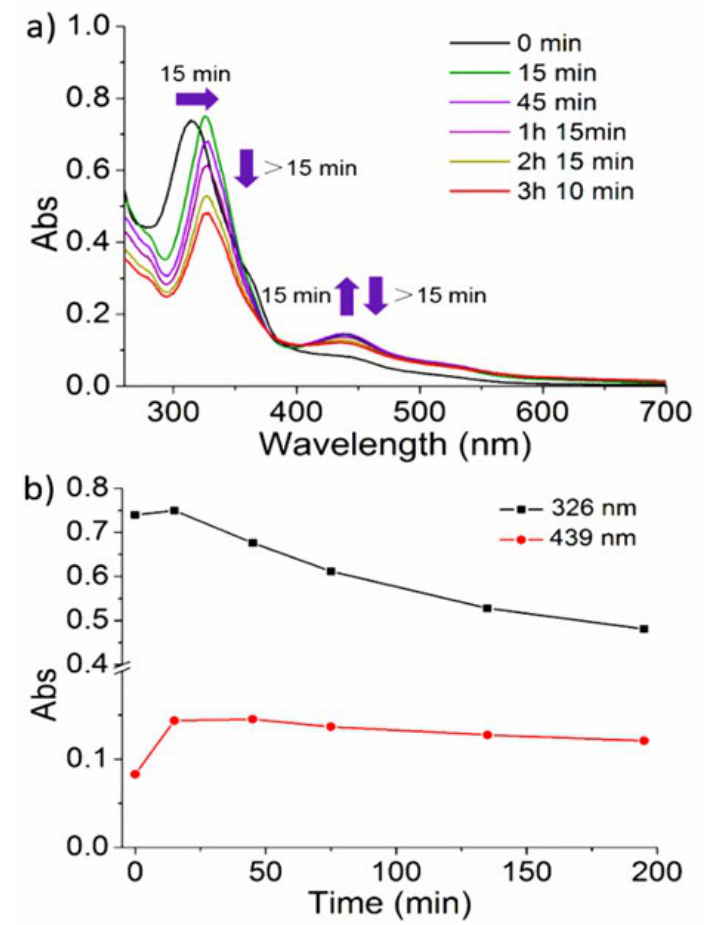
Figure 4. ( a ) Evolution of the UV-Vis spectra of a PBS suspension of RuBIS CPNs upon green light (λ exc = 532 nm); ( b ) plot of absorption changes at 326 nm (black) and 439 nm (red). Irradiation with 450 nm (0.35 W/cm 2 ) for the first 10 min showed a red shift of the main band, from λ max = 315 to 326 nm and an intensity increase in the shoulder at λ abs = 439 nm. Irradiation for longer periods (up to 2.5 h) evidenced an intensity decrease in both bands, including the shoulder at λ abs = 365 nm until its disappearance (Figure S11) and an isosbestic point at λ iso = 406 nm. This time-dependent two-step process was tentatively explained by an initial fast formation of photoinduced intermediate species (t irradiation ≤ 10 min) and a subsequent slower photochemical reaction (t irradiation > 10 min) leading to the forma- tion of the final photoproduct. Irradiation with green light ( λ exc = 532 nm, 0.42 W/cm 2 ) yielded similar results, although the spectral changes occurred more slowly due to the lower absorption of the RuBIS CPNs at the used wavelength. A red shift from λ max = 315 to 326 nm and an increase in intensity at λ abs = 439 nm was observed for the first 15 min of irradiation, while longer irradiation periods (up to 3 h) induced a decrease in the two bands (326 nm and 439 nm) and the formation of an isosbestic point (Figure 4). Interestingly, similar evolution in UV-Vis spectra was observed for the molecular complex 1 under both blue and green light irradiation (Figure S12) [14], which suggests a similar photo-induced process toward the active